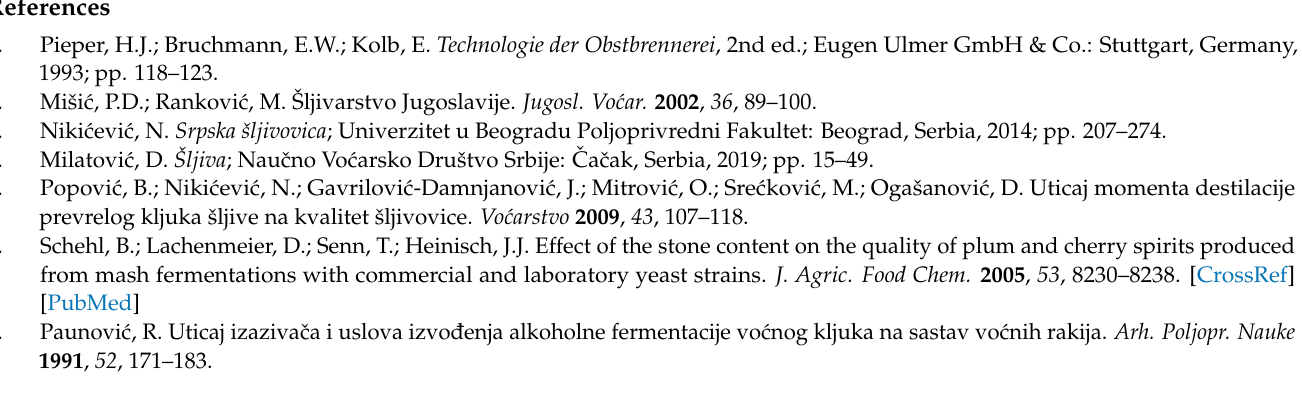
mash without stones; Figure S3: Alcoholic fermentation of plum mash; Figure S4: Kinetics of alcoholic fermentation of plum mashes; Table S1: Results of one-way ANOVA (production method) performed for each parameter; Figure S5: Content of total acids and ingredients prescribed by legal regulations (HCN, methanol, total volatile ingredients) in plum spirits of Požegaˇca (P) and Stanley (S) varieties produced by traditional process (P1 and S1) and modified process (P2–P7 and